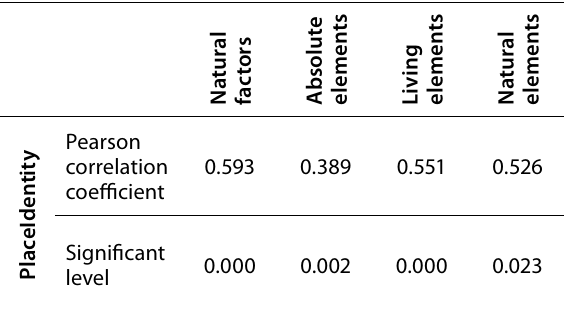
Table 1. The correlation coefficient of hypothesis